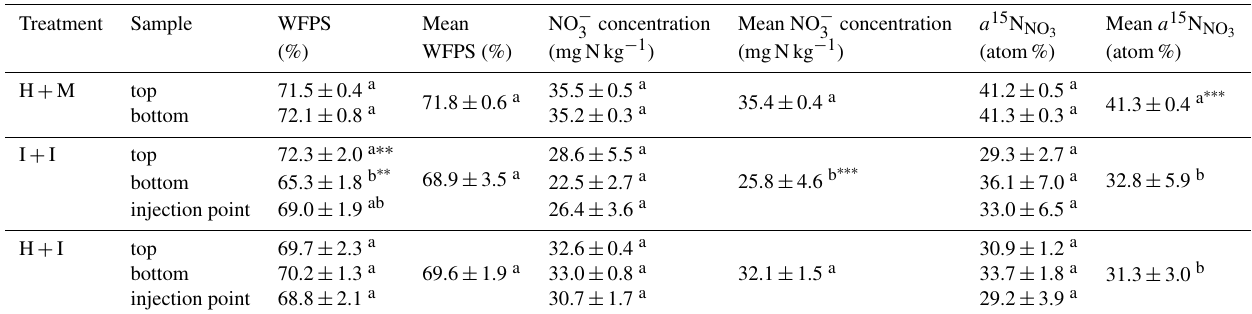
Table 2. Soil analyses at the end of the experiment: mixed samples, and separately from the top and bottom layer and for injected columns also from injection points (including both top and bottom layer). Statistically significant differences are indicated with superscript letters ( ∗∗ p< 0 . 01, ∗∗∗ p< 0 . 001). For individual values the differences within treatment were tested, and for mean values the differences between treatments were